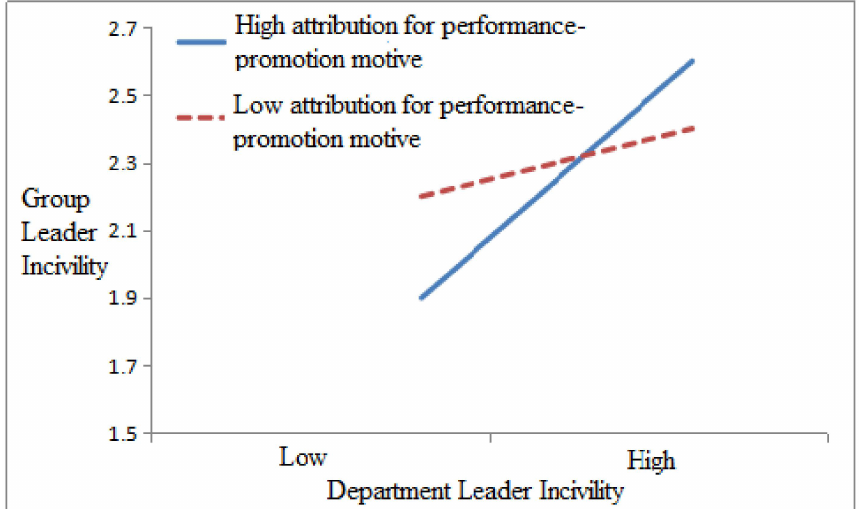
Figure 2. The interactive e ff ect of department leader incivility and group leader attribution for performance promotion motive on group leader incivility.